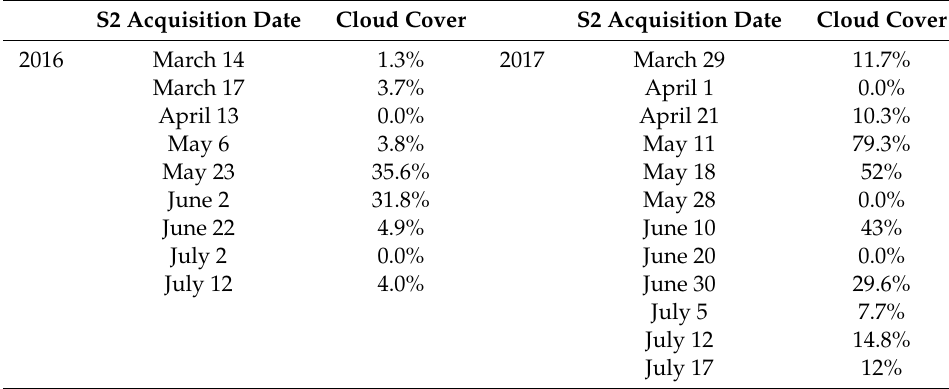
Table 2. List of Sentinel-2 (S2) LAI acquisitions and cloud cover during both the growing seasons of winter wheat in the area of interest (nine in 2016 and 12 in